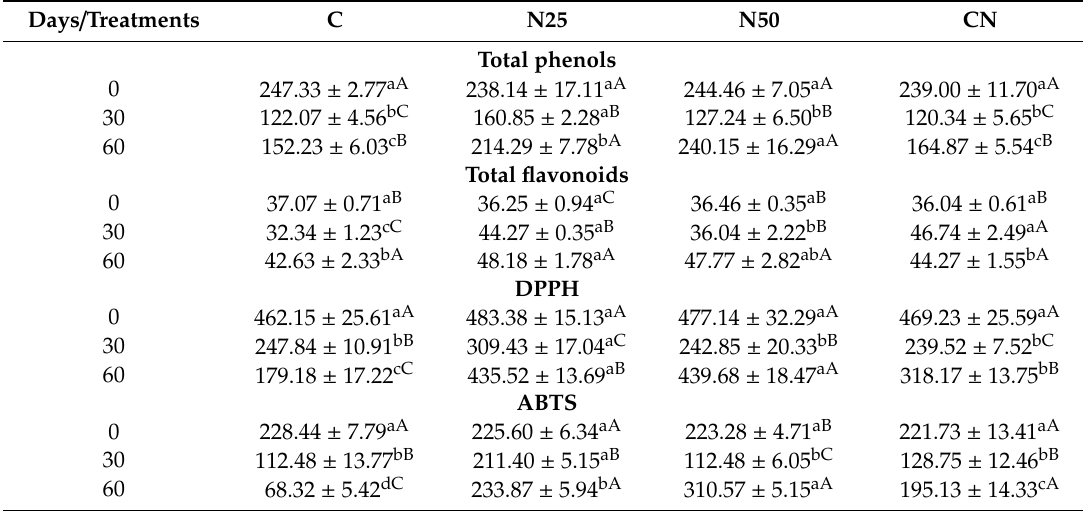
Table 4. Bioactive compounds and antioxidant activity changes in the mesocarp during postharvest. Days /